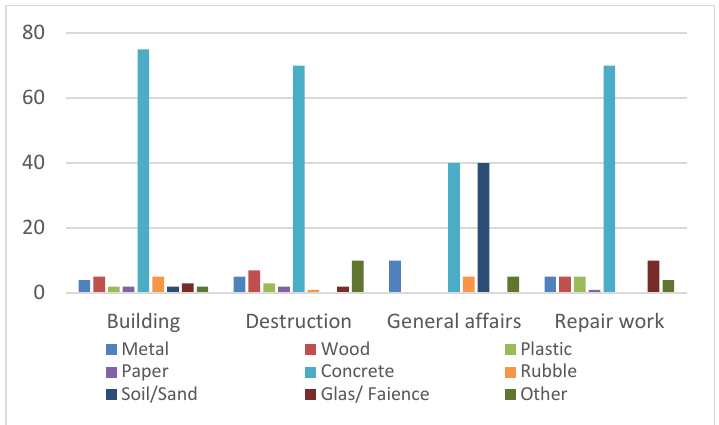
Figure 2. Proportions of construction waste over the lifetime [15]